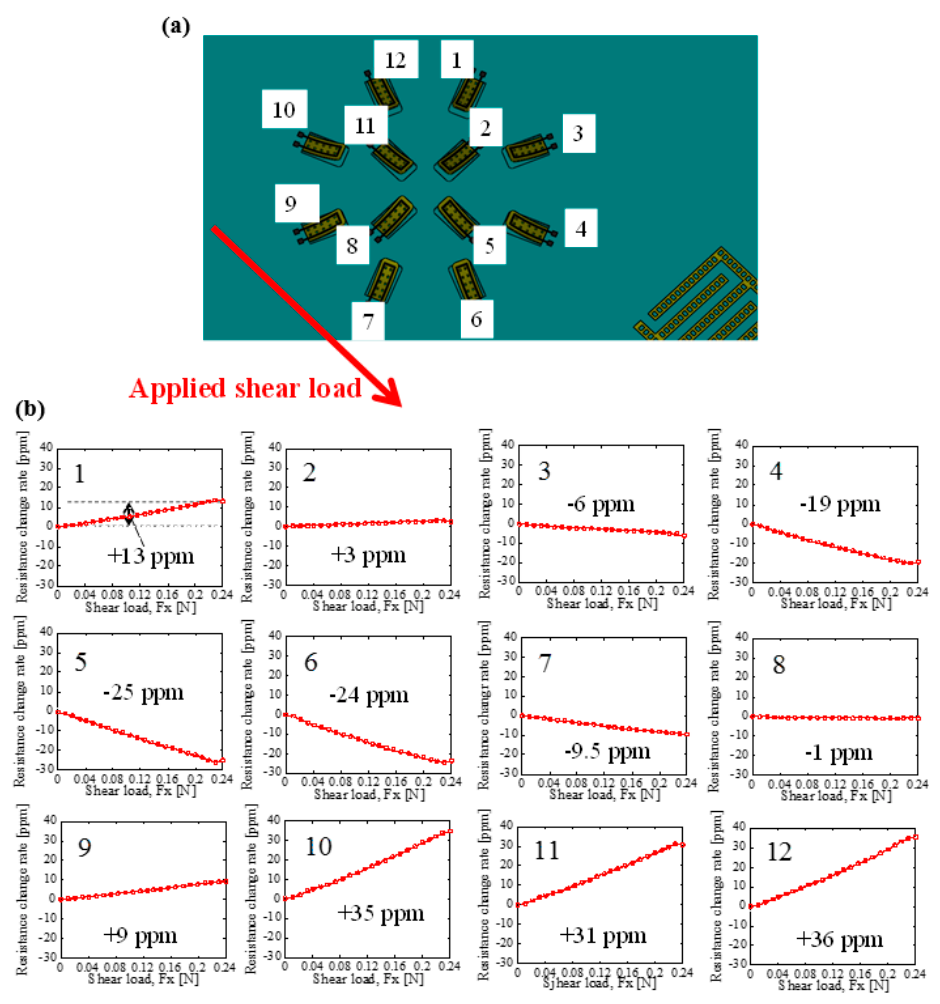
Figure 10. ( a ) A relationship between directions of shear load and cantilevers in Type B sensor, and ( b ) response of the cantilevers to shear